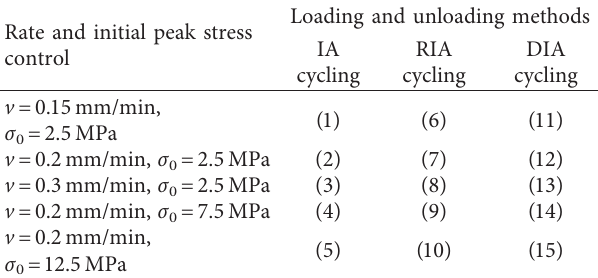
Figure 1: Three loading and unloading methods: (a) IA cycling; (b) RIA cycling; and (c) DIA cycling. Table 4: Loading and unloading